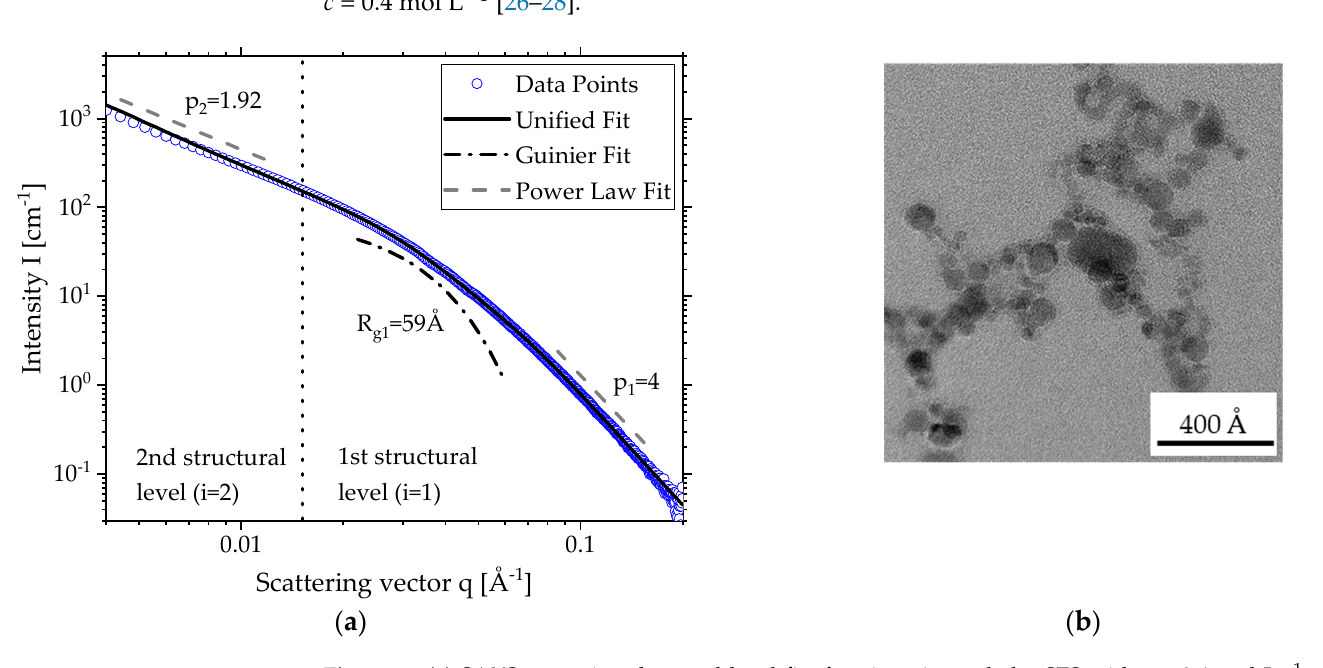
Figure 1. ( a ) SAXS scattering data and local fits for zirconia made by SFS with c = 0.4 mol l − 1 ; ( b ) TEM image for zirconia made by SFS with c = 0.4 mol l − 1 .